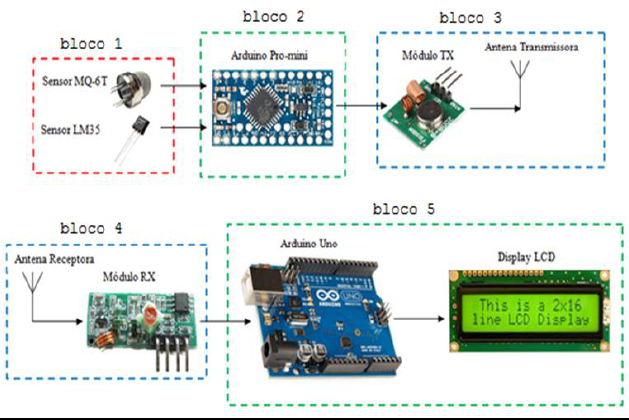
Figura 1: Esquema ilustrativo do protótipo de monitoramento.